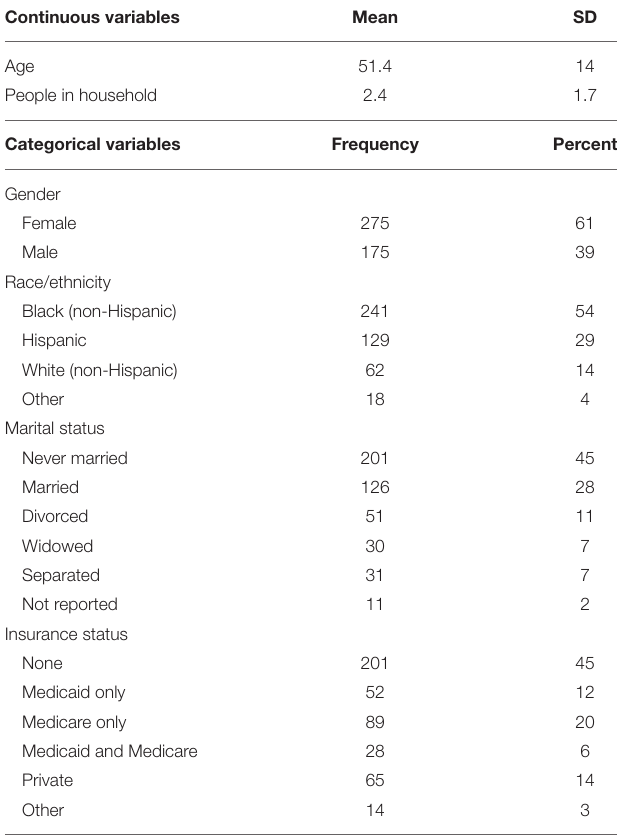
TABLE 1 | Socioeconomic